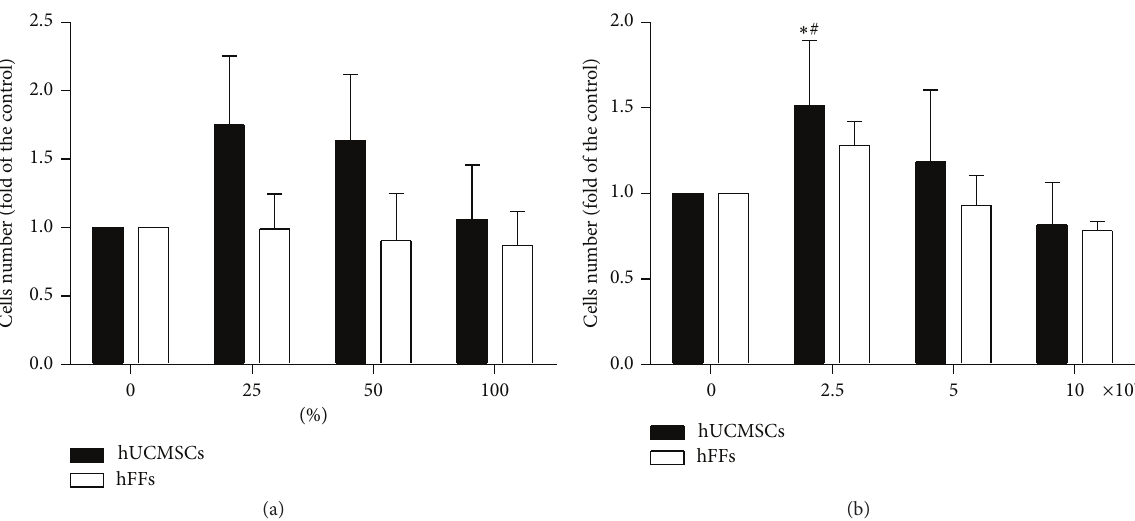
Figure 4: Effect of hUCMSCs and hFFs on the proliferation ability of HTR-8/SVneo cells. (a) HTR-8/SVneo cells (2 × 10 3 cells/well) were cultured in medium containing 0, 25, 50, or 100% hUCMSC or hFF supernatant in 96-well plates for 48 hours. (b) HTR-8/SVneo cells (10 × 10 4 cells/well) were cocultured with hUCMSCs or hFFs at a concentration of 0, 2.5, 5, or 10 × 10 4 cells/well in 6-well Transwell plates for 48 hours. ∗ represents significant differences versus control ( 𝑃 < 0.05 ); # represents significant differences between hUCMSCs and hFFs at an individual dose ( 𝑃 < 0.05